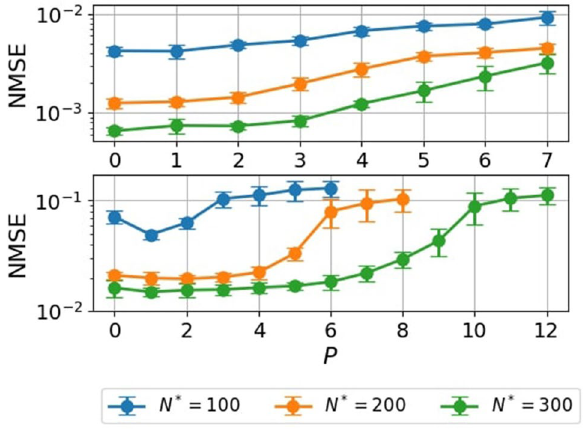
Figure 8. P -dependence of the learning performance. NMSEs for the NARMA5 (the top panel) and NARMA10 (the bottom panel) tasks with delay-state concatenation as functions of P for various values of N ∗ . Error bars show the standard deviation of the results of 10 trials.